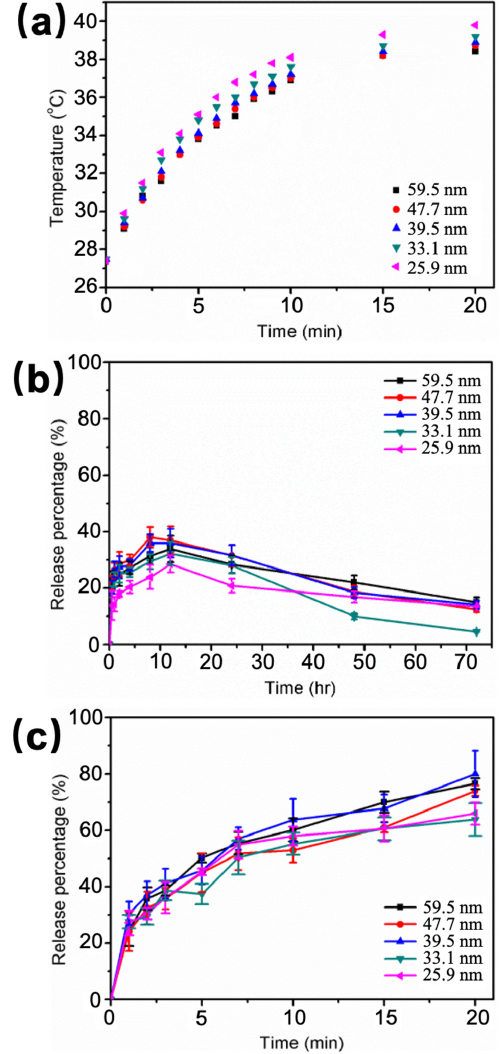
Figure 5. ( a ) Size effect on the temperature increase after applying HFMF for different periods of time. ( b ) Size effect on the DOX release profile from DOX-loaded Fe 3 O 4 @AuNPs-dsDNA by diffusion at 37 °C. ( c ) Size effect on DOX release ability when applying HFMF. Table 3. SLP values of various Fe 3 O 4 @Au NP sizes.